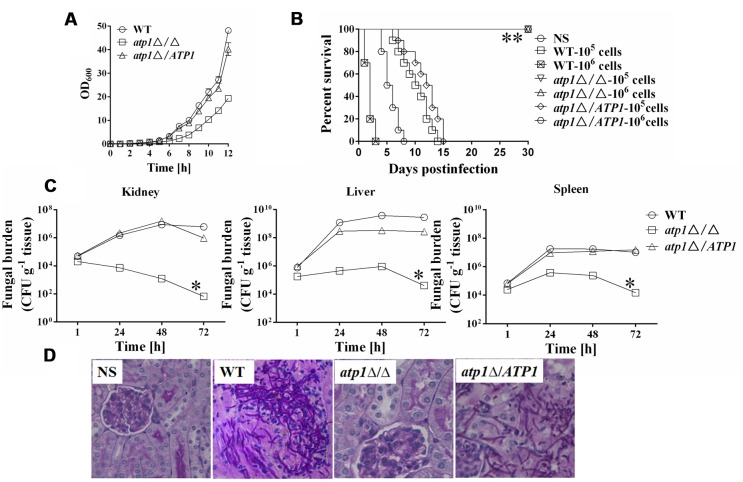
Deletion of ATP1 results in avirulence in a mouse model of hematogenously disseminated candidiasis. (A) Reduced growth rate of the atp1Δ/Δ was determined by measuring the OD600 of cells growing in YPD at 30°C. (B) Mice survival following infection with 1 × 105 and 1 × 106 cells of the Candida albicans. ∗∗
P < 0.0001 compared to mice infected with WT. (C) Fungal burden (CFU/g tissue) of mice infected with 1 × 106 cells of the C. albicans. Following infection, at 1, 24, 48, and 72 h, kidney, liver and spleens were removed, weighed, homogenized and samples plated on YPD agar medium. The total CFUs in tissue for each strain were shown over time. Data are from two experiments with three mice per time point for each strain (mean ± SD). ∗P < 0.05 compared to mice infected with WT. (D) Periodic acid Schiff staining of kidney sections from mice after 1 day of infection with C. albicans. Pictures were taken at 40× magnification.